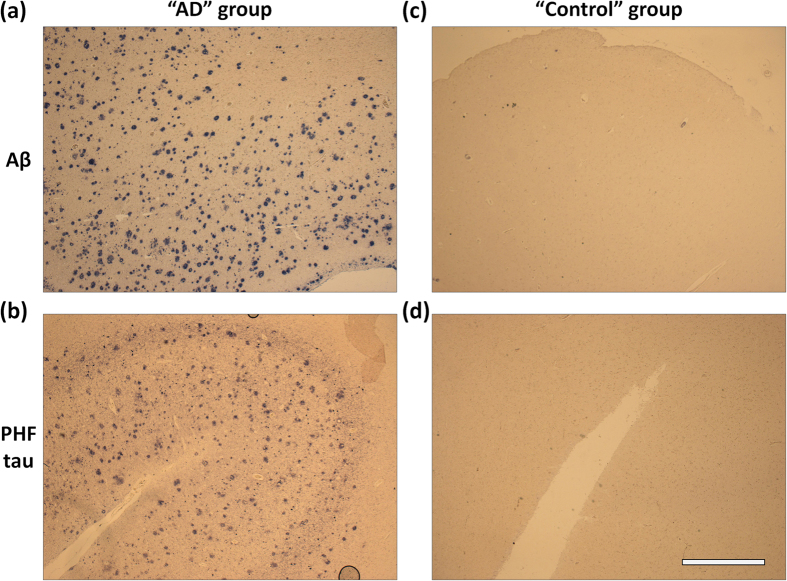
IHC staining of FFPE brain tissue sections with Ab/PrA-ssDNA probes.Representative FFPE brain tissue sections from “Alzheimer’s disease (AD)” (a,b) and healthy “Control” (c,d) groups were labeled for either Aβ (a,c) or PHF-tau (b,d) pathologic proteins with corresponding 1′Ab/PrA-ssDNA probes and complementary ssDNA′-AP reporters. Localization of labeled proteins was highlighted by a precipitating chromogenic AP substrate (dark spots) and examined via brightfield microscopy. Scale bar, 1 mm.